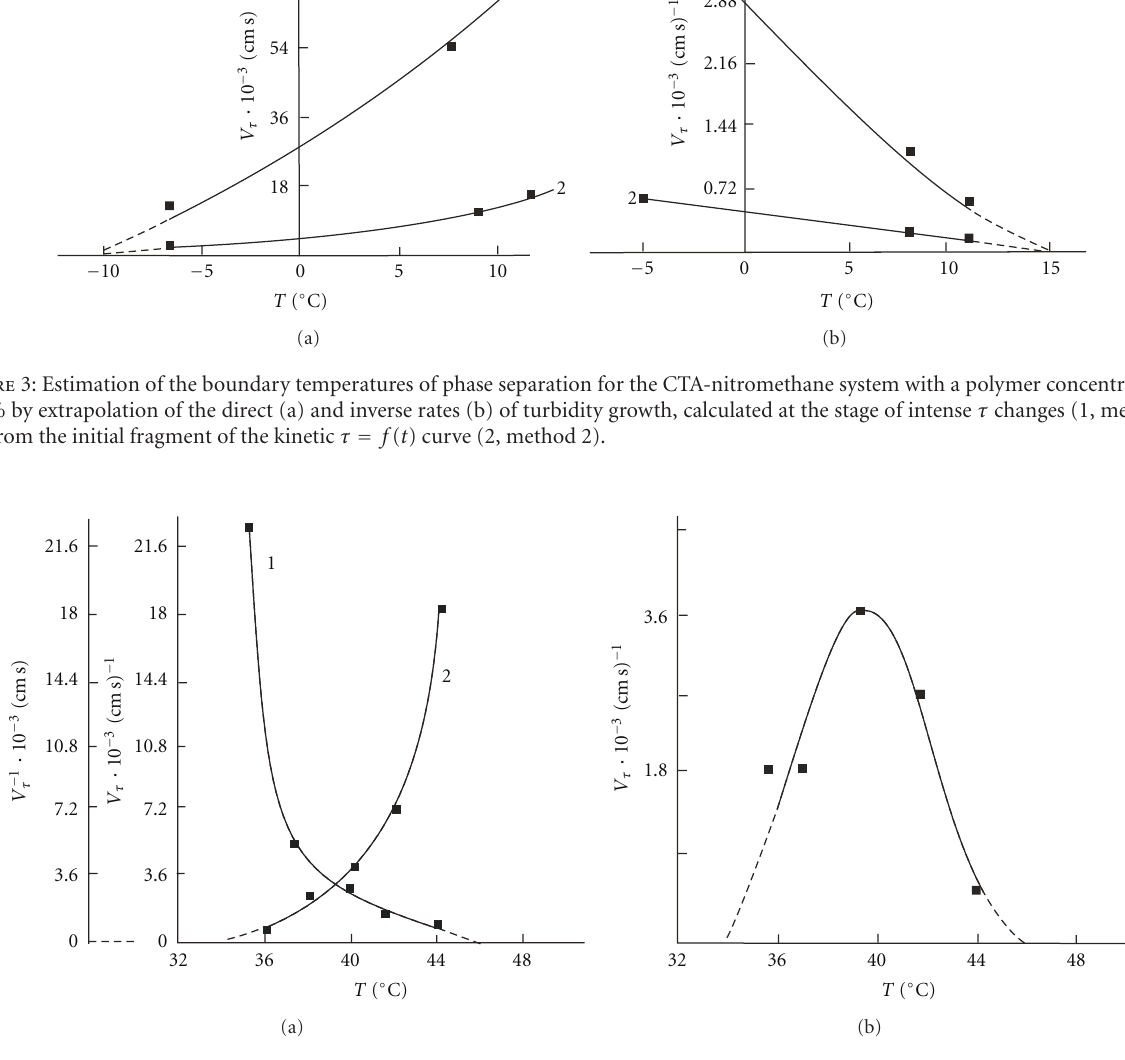
Figure 4: Estimation of the boundary temperatures of phase separation for the CTA-nitromethane system with a polymer concentration of 9wt%: (a) by the extrapolations V τ ( T ) → 0 (1) and V − 1 τ ( T ) → 0 (2) for the rate calculated from the τ = f ( t ) fragment of intense turbidity growth (method 1); (b) by the extrapolation V τ ( T ) → 0 for V τ determined from the initial fragment of the kinetic τ = f ( t ) curve (method